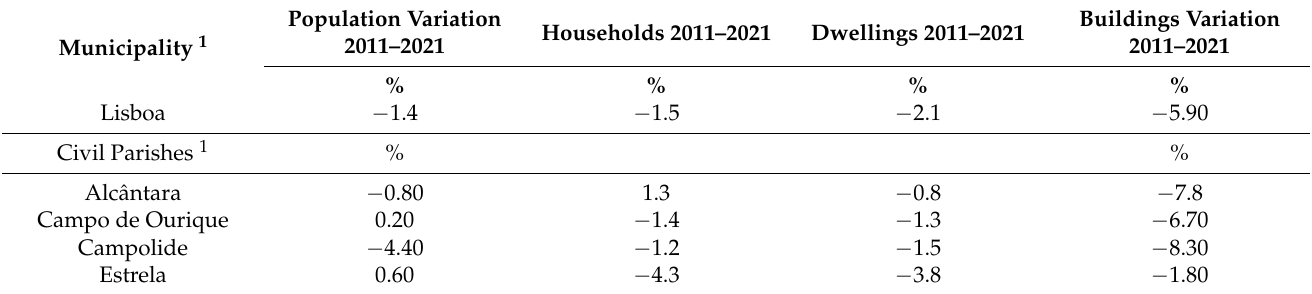
Table 2. Population and Buildings Variation, Census 2011–2021. Lisbon Municipality and the Districts partially affected by the PUA—Alc â ntara Urban Development Plan. Source: Adapted from INE/Statistics Portugal, INE/Statistics Portugal, Preliminary data, Census 2021, available